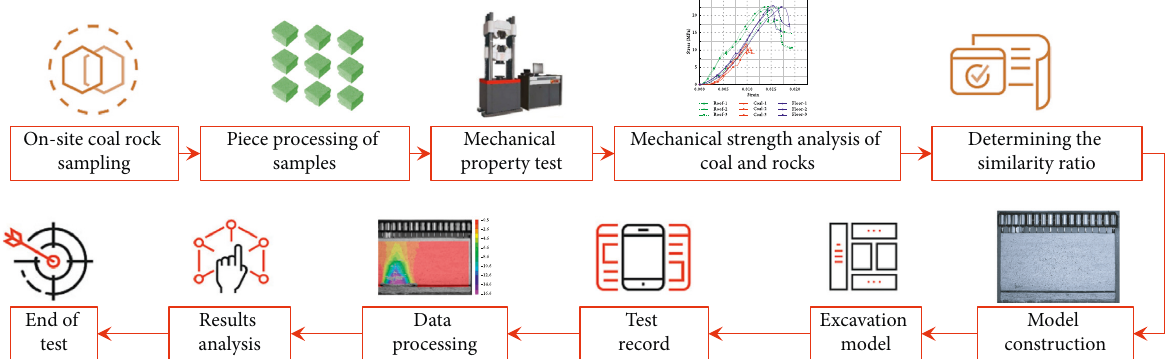
Figure 3: Experiment and research process.